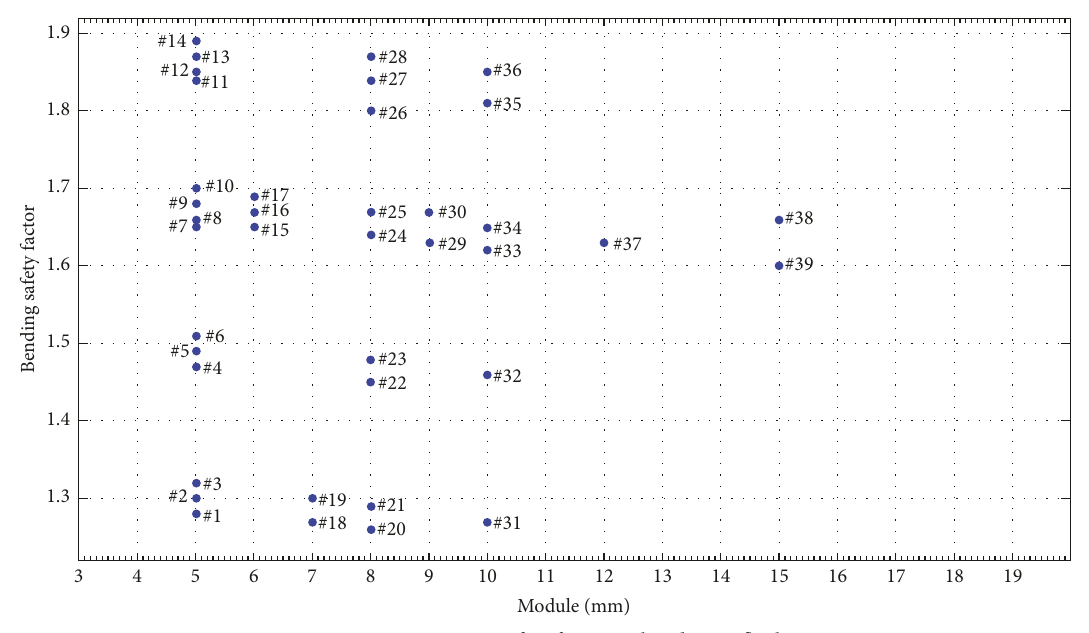
Figure 19: Minimum safety factor on bending at